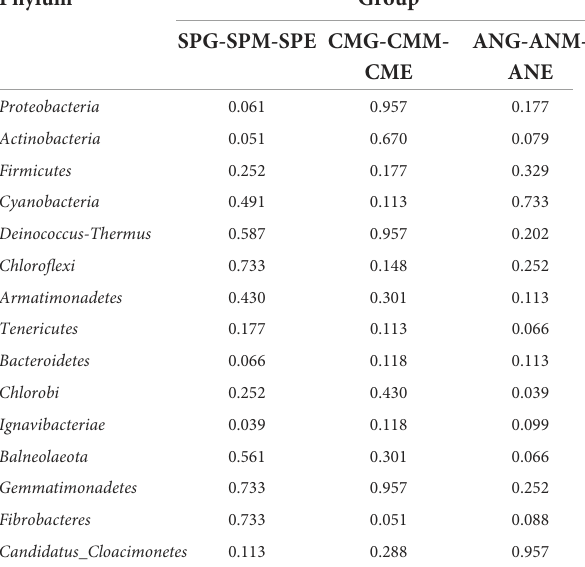
TABLE 1 Kruskal-Wallis test of the top 15 rhizosphere soil microorganisms under different grassland utilization patterns at phylum